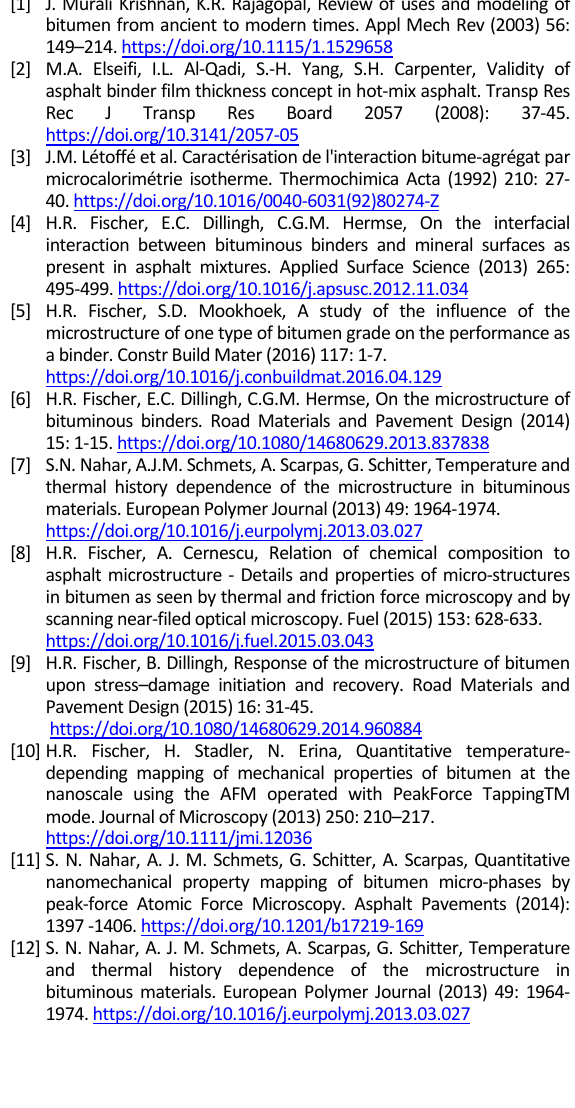
Figure 5. Phase contrast image of the binder part only showing spiral crystal features in the circle (peri ‐